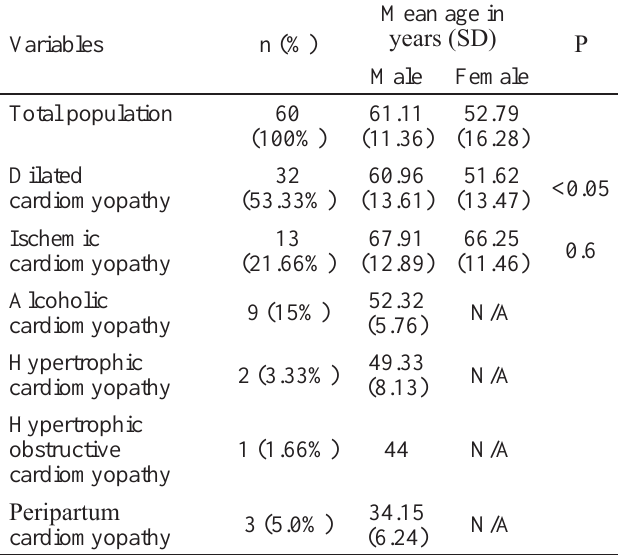
Table 1: Baseline characteristics of patients with cardiomyopathy Variables